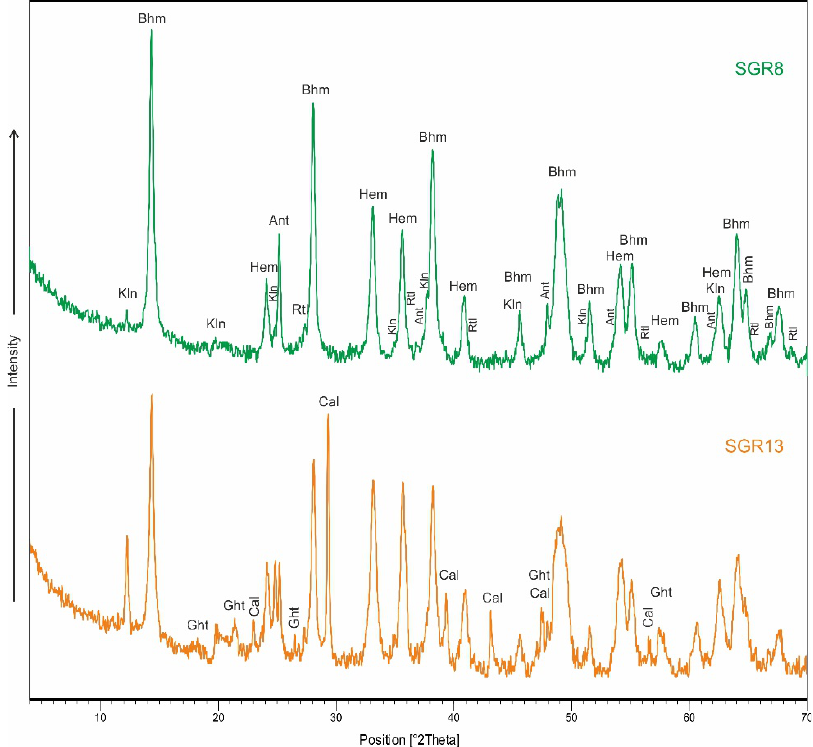
Figure 3. XRPD results of two SGR samples representative of the upper and lower portions of the deposit. Ant = anatase, Bhm = boehmite, Cal = calcite, Ght = goethite, Hem = hematite, Kln = kaolinite, Rtl = rutile.